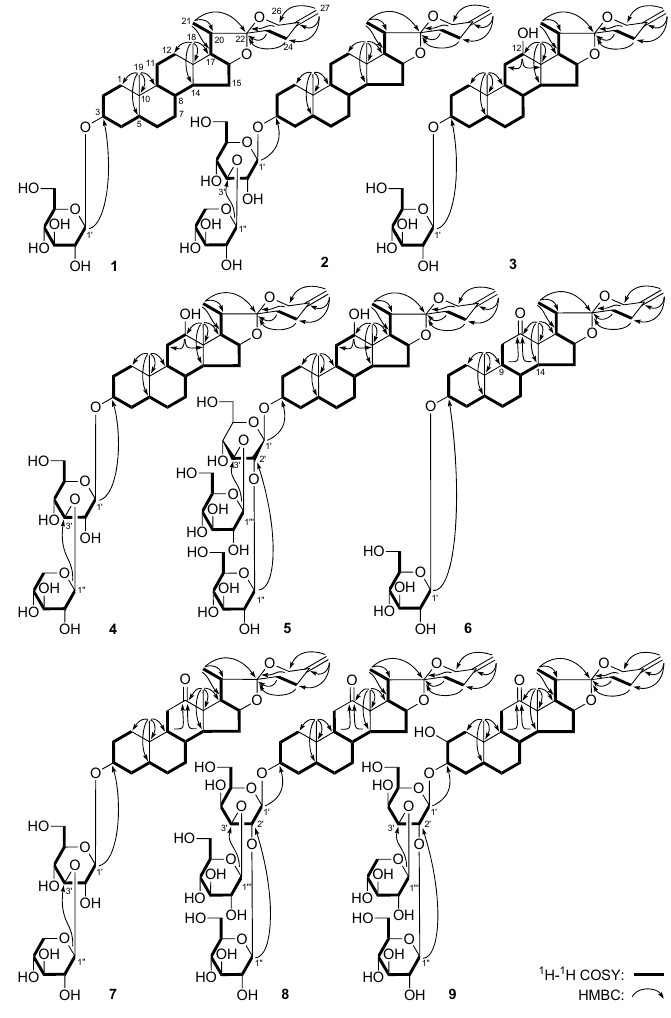
Figure 2. The main 1 H– 1 H COSY and HMBC correlations of 1 – 9 .